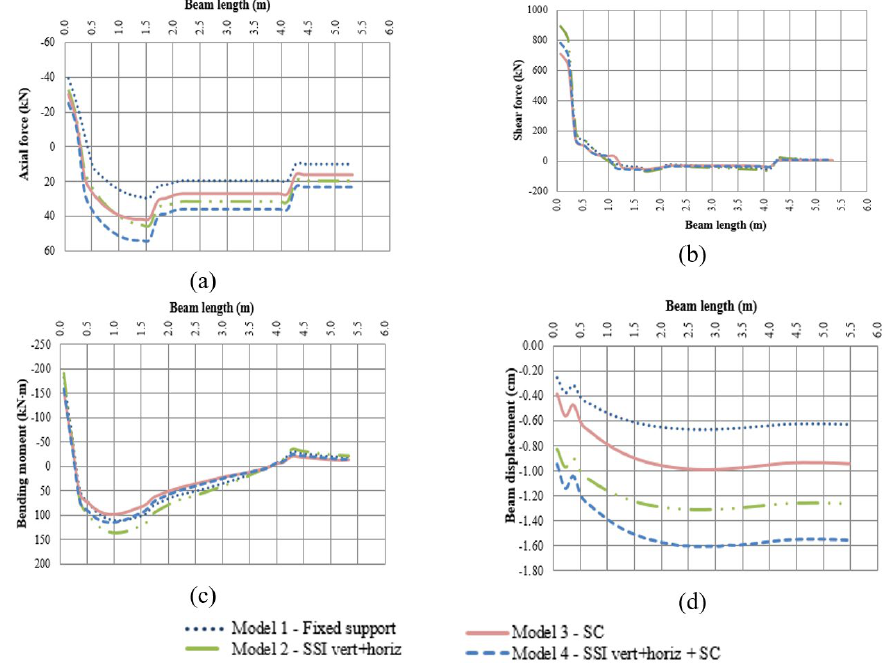
Figure 12. Forces on the support beam of wall 45: (a) Axial force; (b) Shear force; (c) Bending moment; (d) Displacements.